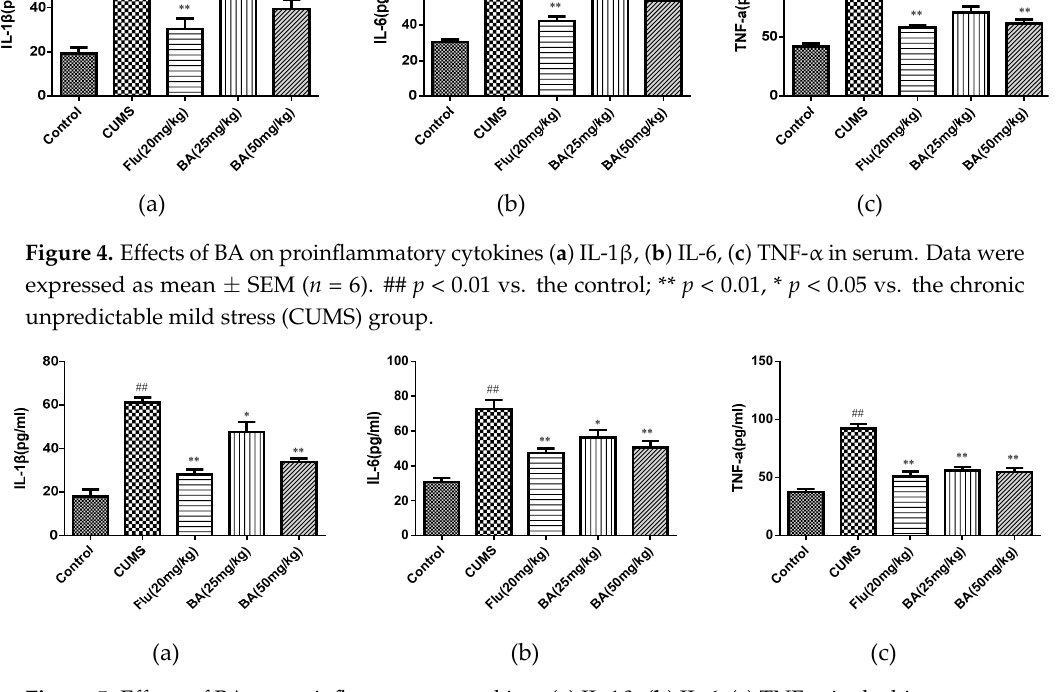
Figure 5. Effects of BA on proinflammatory cytokines ( a ) IL-1 β , ( b ) IL-6, ( c ) TNF- α in the hippocampus tissues. Data were expressed as mean ± SEM ( n = 6). ## p < 0.01 vs. the control; ** p < 0.01, * p < 0.05 vs. the CUMS group.